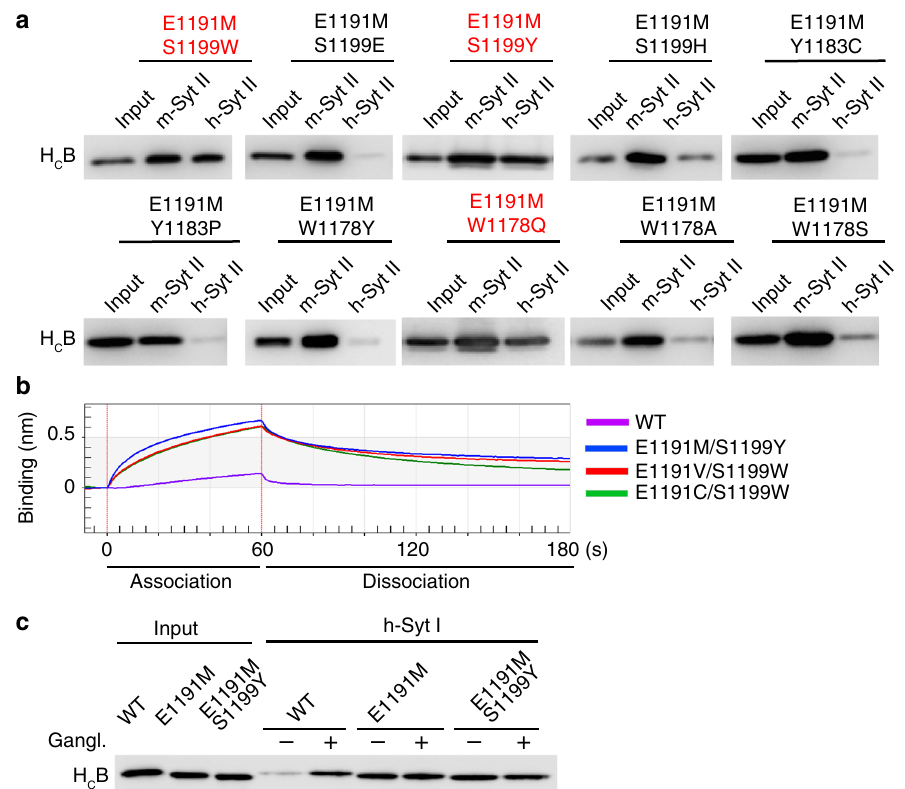
Fig. 2 Combinational mutations in H C B enhance its binding to h-Syt II and Syt I. a H C B double mutations were examined in pull-down assays for their abilities to bind m-Syt II vs. h-Syt II. Three double mutations that showed robust binding to h-Syt II are marked in red . One of two independent experiments is shown. b Binding of H C B to h-Syt II was quanti fi ed by the BLI assay. Representative association and dissociation curves are shown for WT H C B and three H C B mutants: E1191M/S1199Y, E1191V/S1199W, and E1191C/S1199W. Binding parameters for all 12 double mutations are listed in Table 1, and their representative binding traces are shown in Supplementary Fig. 3. c Binding of WT H C B, H C B (E1191M), and H C B (E1191M/S1199Y) to immobilized GST-tagged h-Syt I (residues 1 – 80) was examined in pull-down assays, with (+) or without ( − ) gangliosides (Gangl.). Binding of WT H C B to h-Syt I requires the presence of gangliosides, while H C B (E1191M) and H C B (E1191M/S1199Y) bind to h-Syt I in the absence of gangliosides. One of two independent experiments is shown. Further analysis of H C B binding to h-Syt I by the BLI assay is shown in Supplementary Fig. 4 and Table